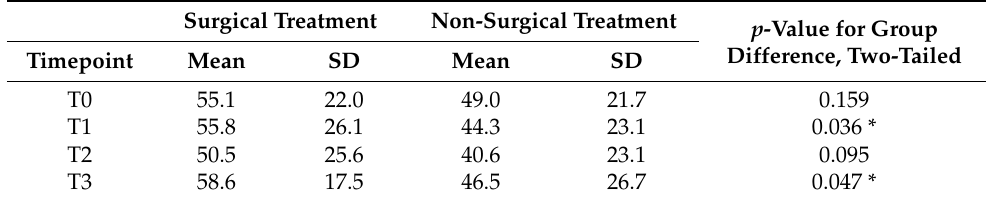
Table 3. Descriptive statistics QLQ-C30 global health status (* p < 0.05. Equality of variance assumed, two-tailed t